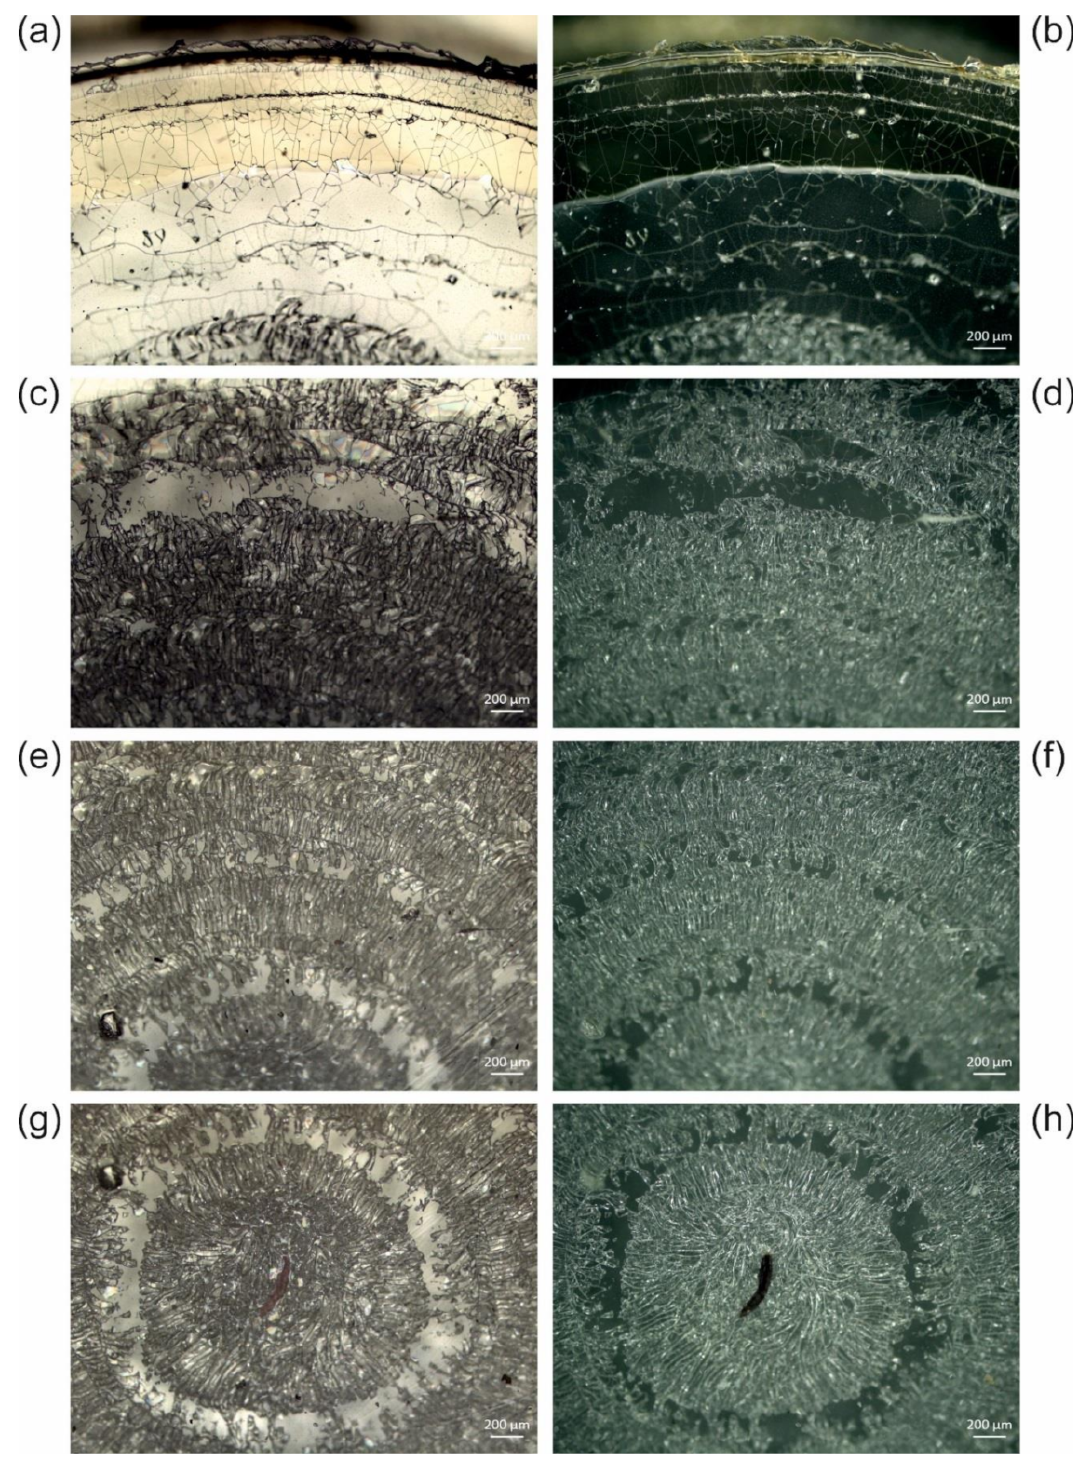
Figure 7. ( a , c , e , g ) Reflected light brightfield and ( b , d , f , h ) reflected light darkfield micrographs of sample USNM 1226550, Cateria gerlachi , in Permount TM , from the edge of the cover slip ( a , b ) towards the centre ( g , h ), showing cracks in concentric rings with stronger interconnections than in sample USNM 1226536, Cateria gerlachi (Figure 6). Due to high optical density, transmitted light images were not